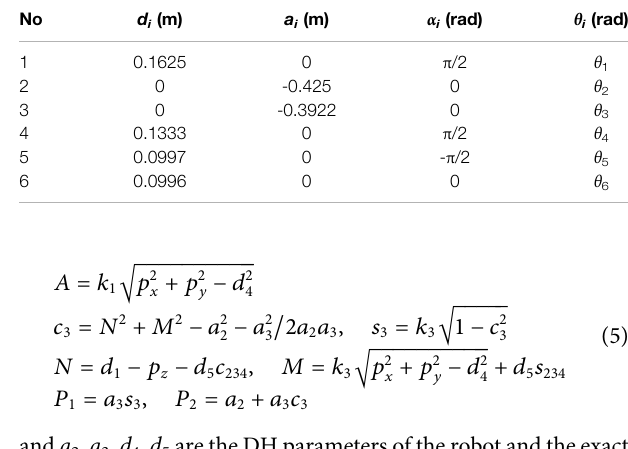
TABLE 1| DHparameters ofUR5cobot,including linkoffset d i ,linklength a i ,twist angle α i and joint angle θ i